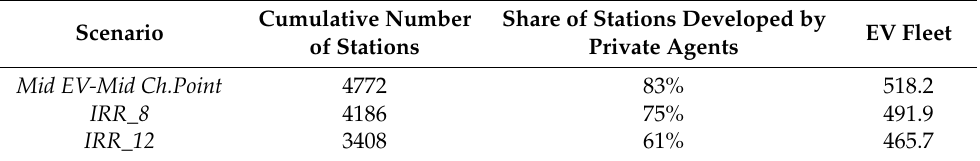
Table 14. Share of charging stations deployed by the private sector in 2030.